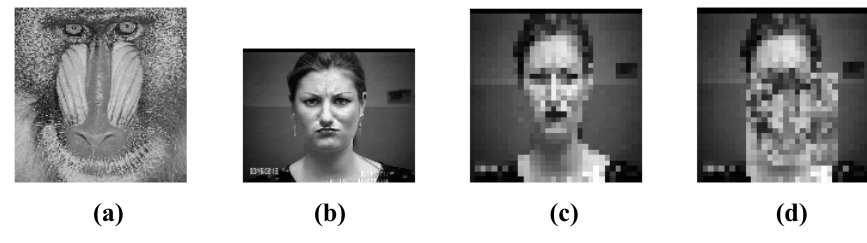
Figure 7. An occluded image example ( a ) Baboon; ( b ) Original image of 640 × 490 pixels;